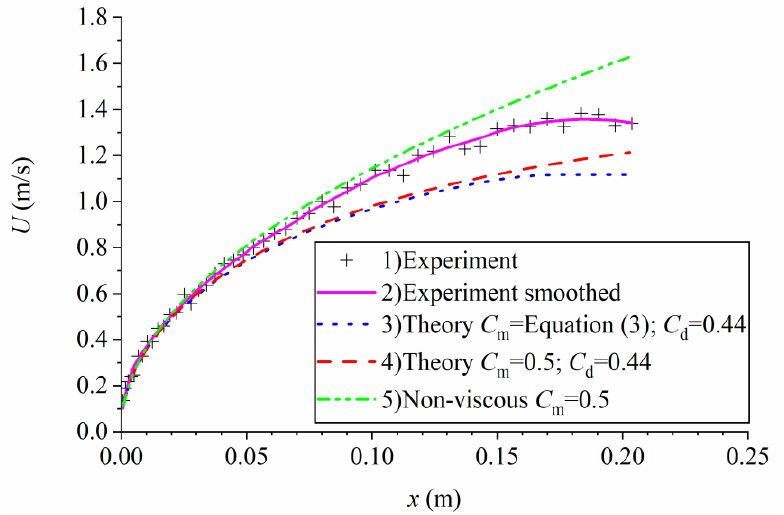
Figure 6. Variations of the velocity of the sphere along with displacement before colliding the ice plate for the case ρ = 0.4, L 0 = 2.31 and h = 0.089.